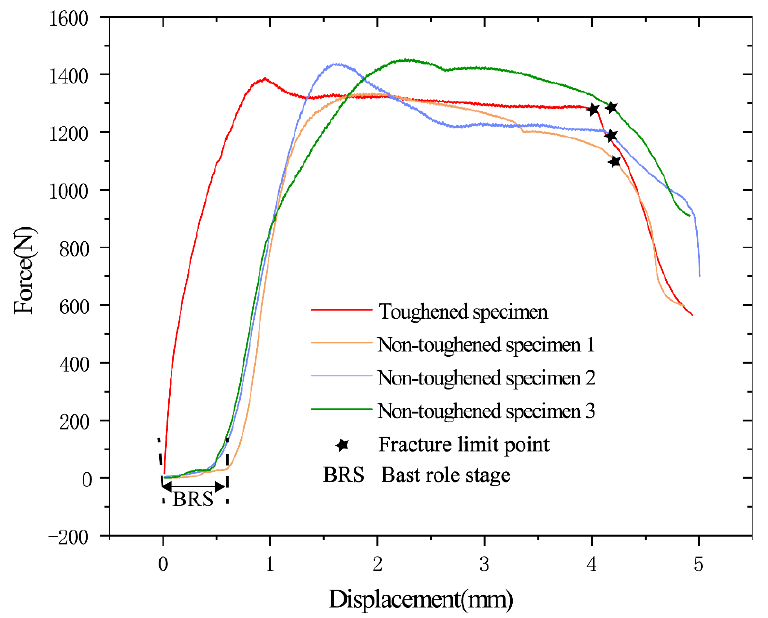
Figure 1. Green pepper branches are toughened or non-toughened, three points of compression.